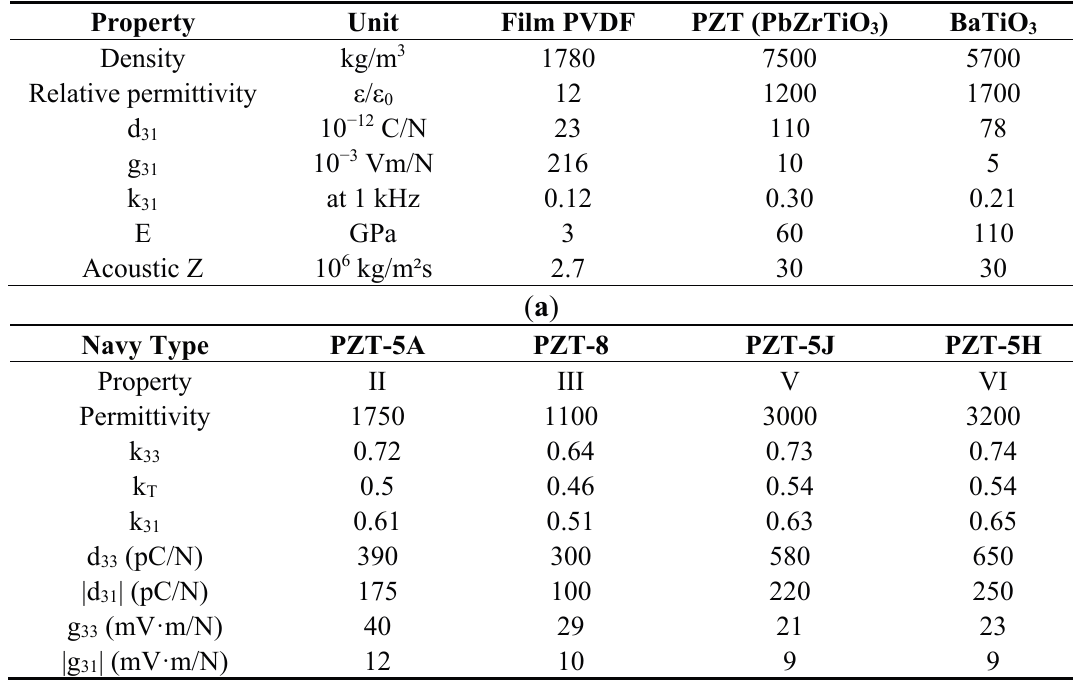
Table 1. ( a ) Properties of different piezoelectric materials; ( b ) Properties of different PZT types. Property Unit Film PVDF